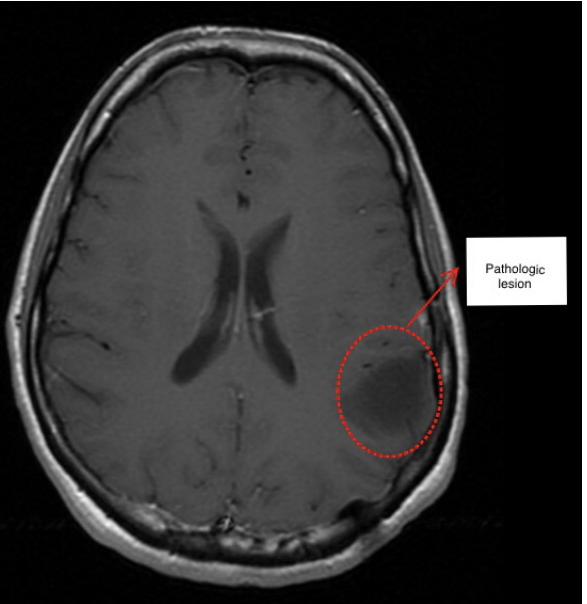
Figure 6. Experimental assessment, second scenario. A patient with pathology located in the left parietal lobe of the brain.